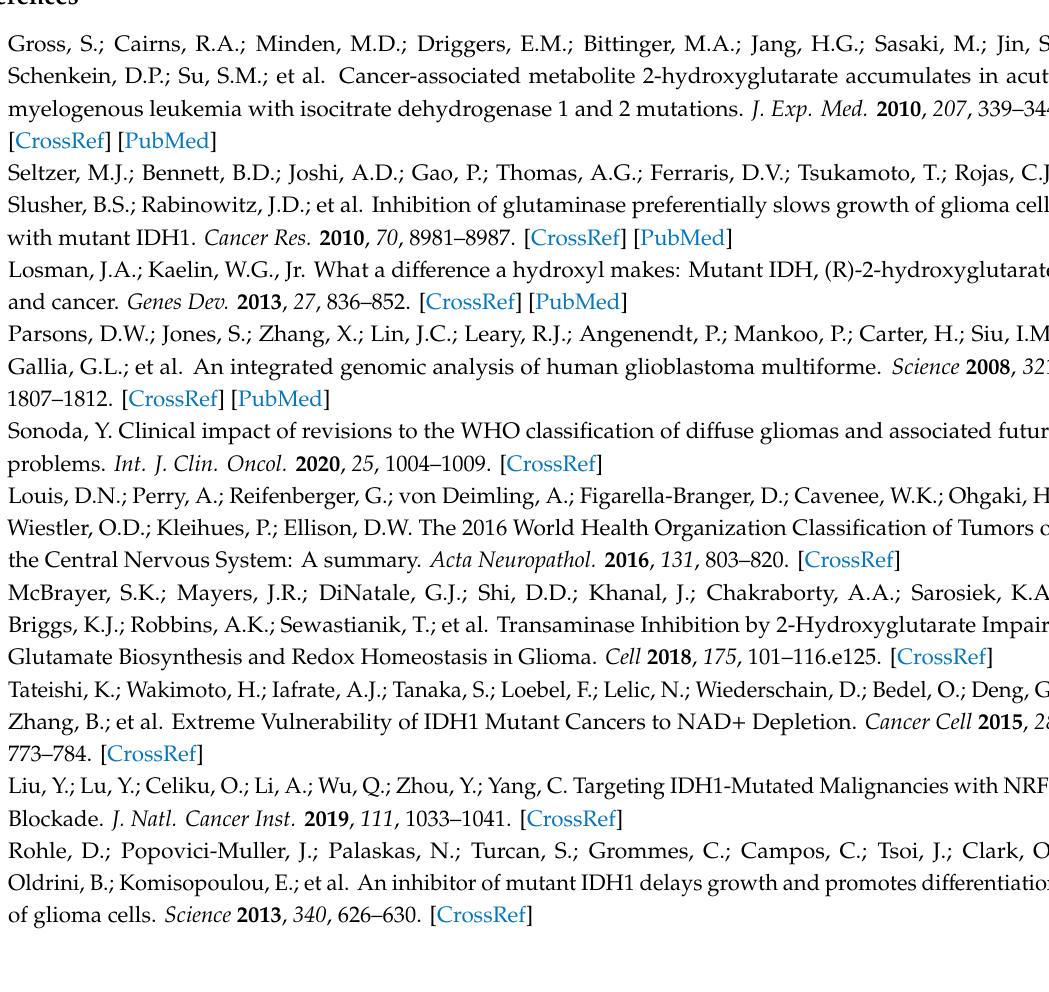
Figure S1: Western Blots for ASAH2, SMPD3, SPHK1, SPHK2 and a-Tubulin; Figure S2: The e ff ect of SPHK1 inhibitor PF-543 on BT142 and TS603 cell morphology, Figure S3: Full WB blot images from Figure 3f,g, Table S1: Sphingolipids and polar lipid analysis for BT142 untreated and treated with AGI5198, Table S2: Sphingolipids and polar lipid analysis for TS603 untreated and treated with AGI5198, Table S3: ER sphingolipids analysis for U251 WT , U251 R132H and U251 R132H + AGI5198, Table S4: Histological and Methylation Types of Tissue Present in Clusters EC1-EC6, Table S5: EC50 for SphC17, NDMS and combination